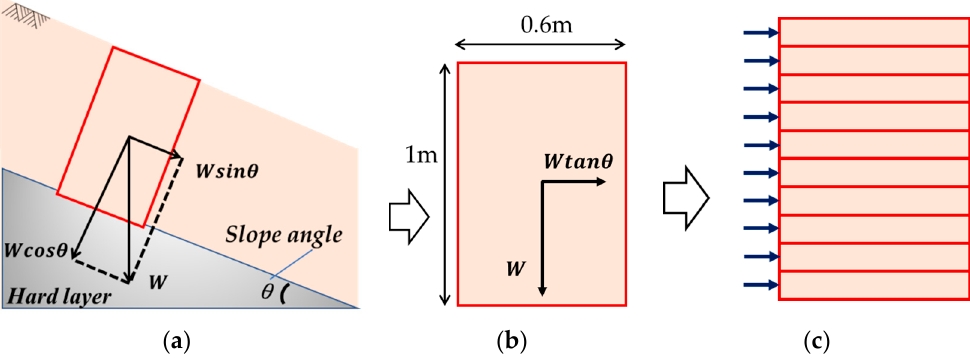
Figure 2. The concept of the multi-layer shear model used in the lab experiment. ( a ) A part of the soil cut out from an infinitely long slope surface layer. The horizontal direction force can be expressed by tan 𝜃 times the weight of the soil. ( b ) The force ratio is the same as it turned to the horizontal direction. ( c ) The 1 m model is divided into the multi-layer model, the horizontal force is loaded on every layer, and every layer can undergo shear deformation independently.